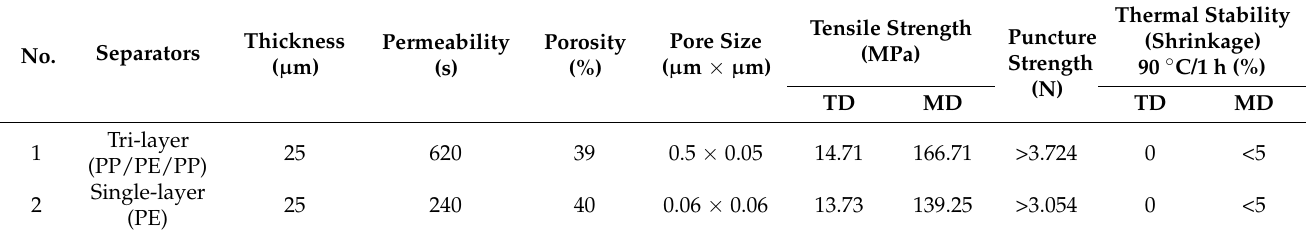
Table 1. Fundamental properties of tri-layer polypropylene/polyethylene/polypropylene (PP/PE/PP) and single-layer polyethylene (PE) [30–32].